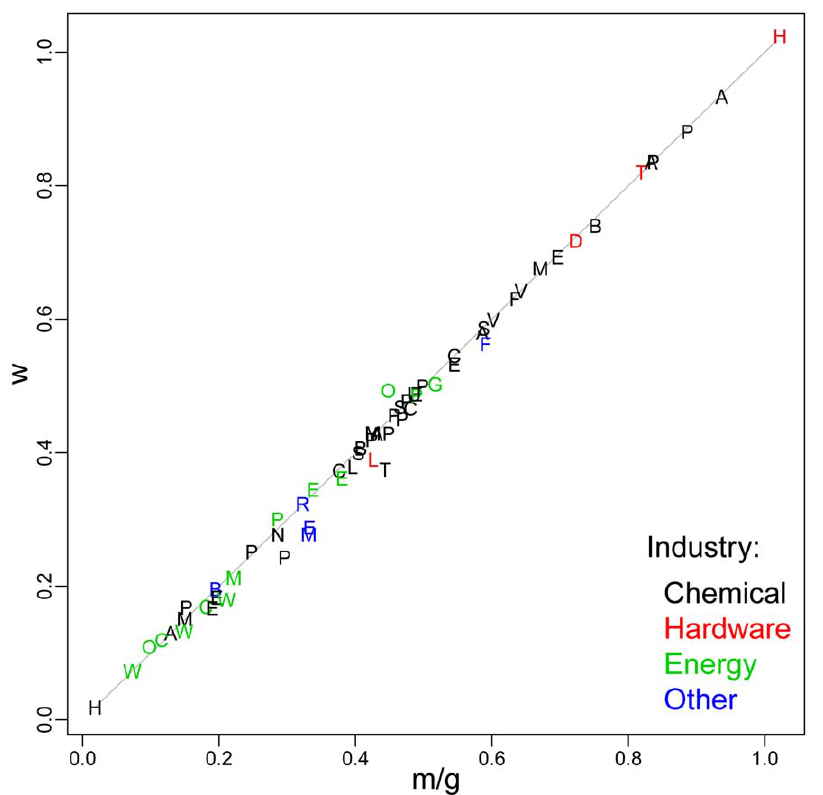
Figure 4. An illustration that the combination of exponentially increasing production and exponentially decreasing cost are equivalent to Wright’s law. The value of the Wright parameter w is plotted against the prediction m = g based on the Sahal formula, where m is the exponent of cost reduction and g the exponent of the increase in cumulative production.